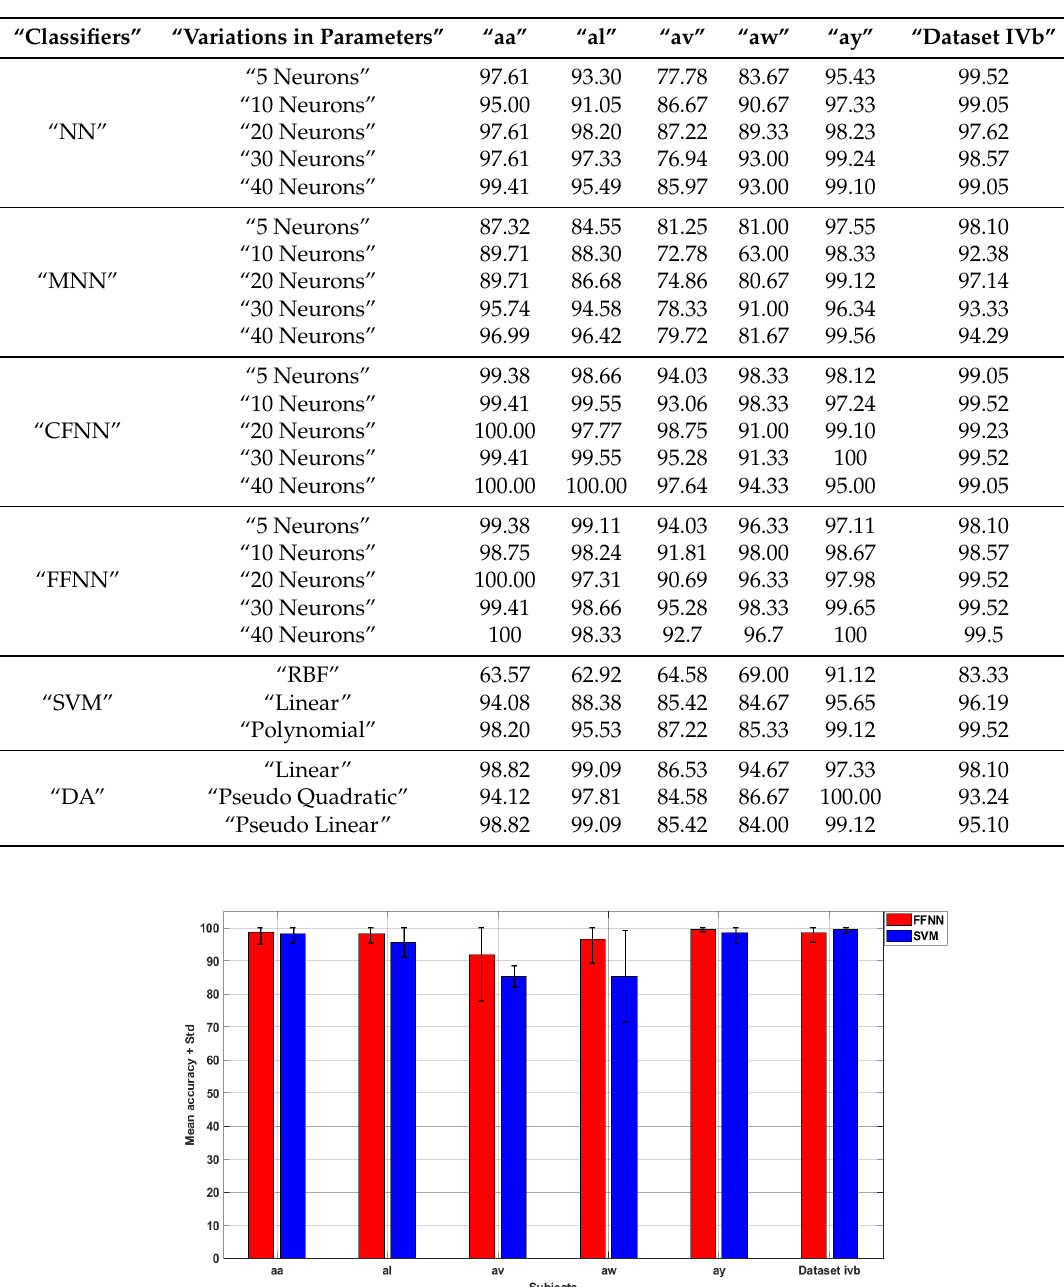
Table 3. Classification (%) results for different parameters of the classifier.